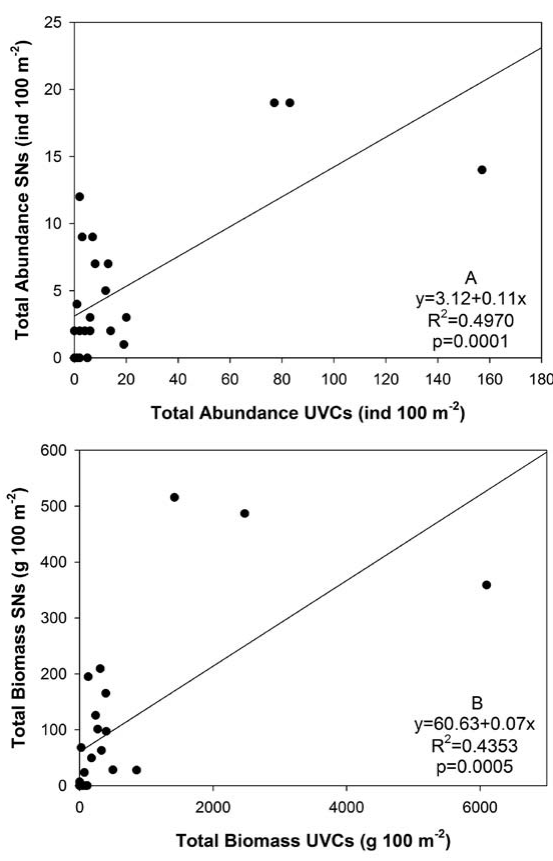
Fig. 7. – Relationships between the total abundances (A) and total biomasses (B) of the pearly razorfish, Xyrichtys novacula , recorded through UVCs and